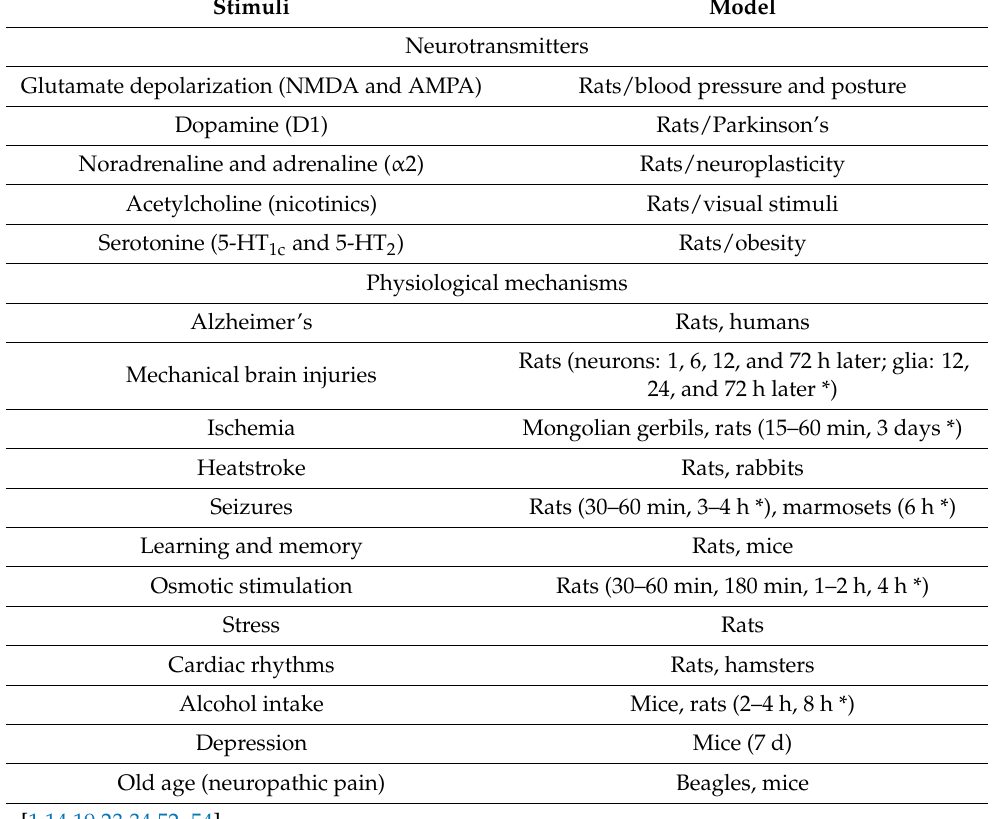
Table 4. Fos-triggering stimuli and their animal